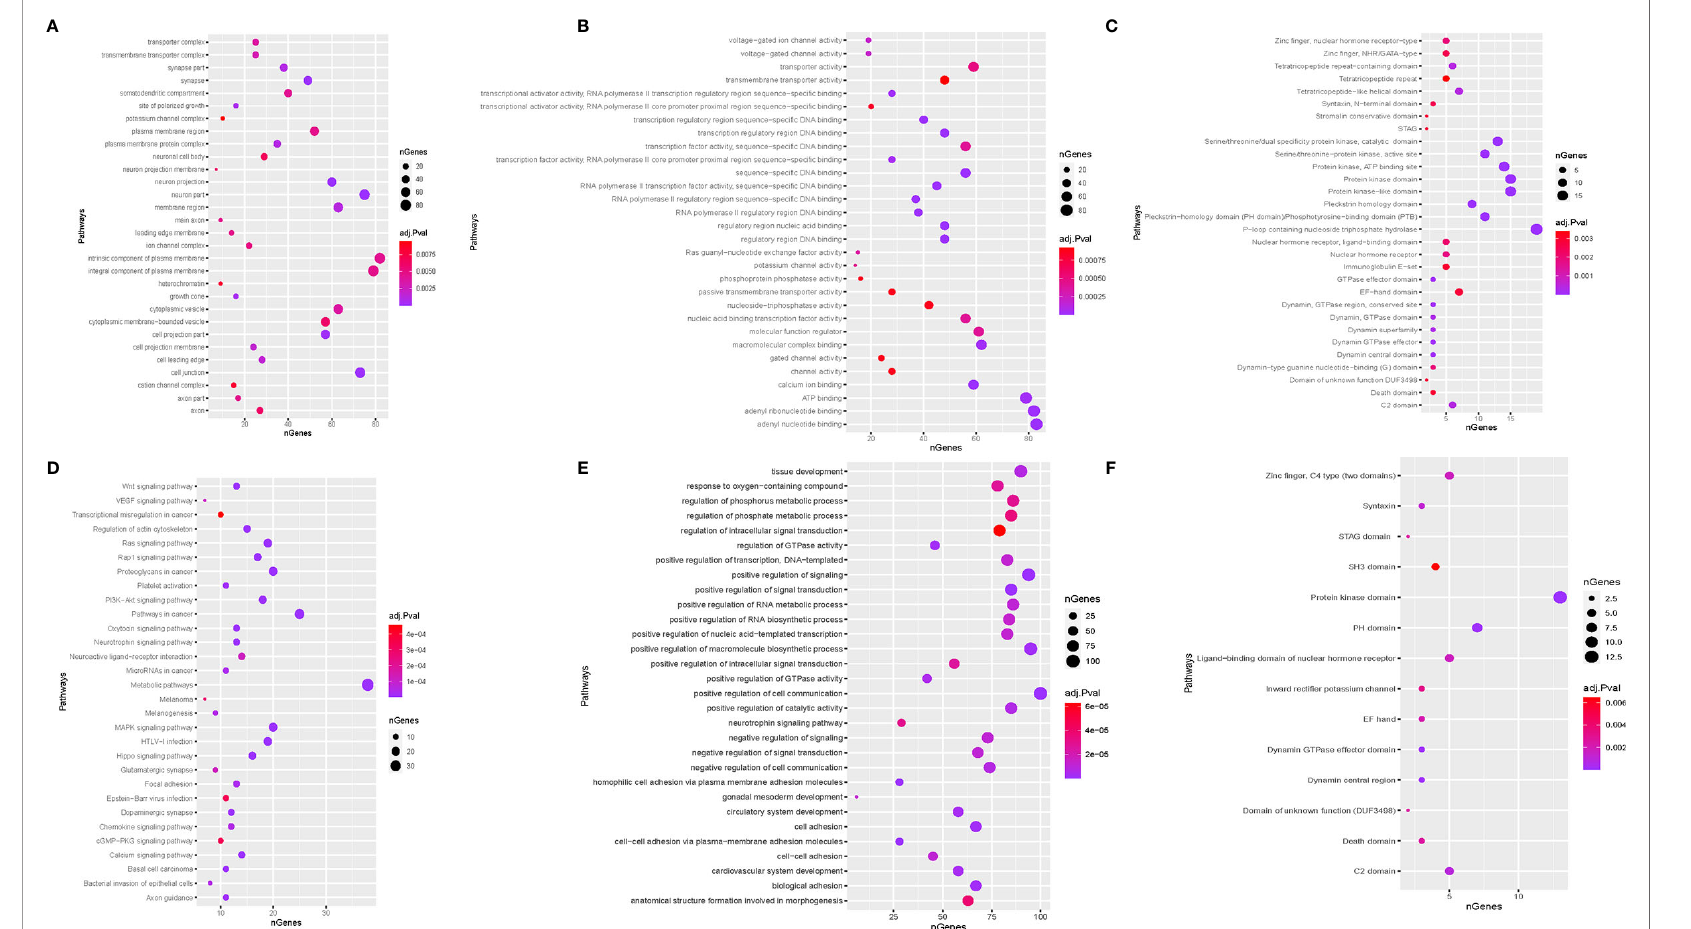
FIGURE 5 | Function enrichment analysis. (A) biological process; (B) cellular component; (C) , molecular function; STRING-db enrichment in (D) Pfam; (E) KEGG; (F) interPro